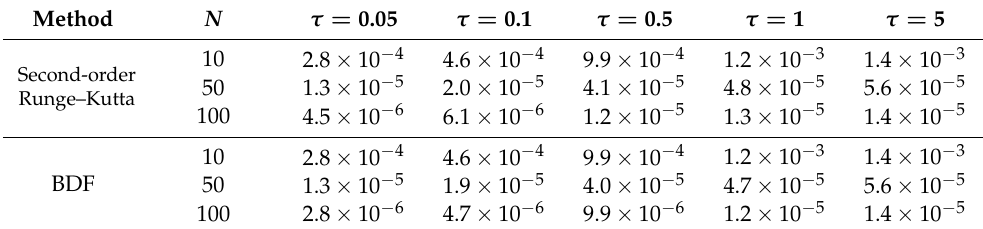
Table 1. The absolute errors of the numerical solutions of test problem 1 for a = 1, k = 0.5, s = 0.2 and five different delays τ on the interval 0 ≤ t ≤ T = 50 τ .